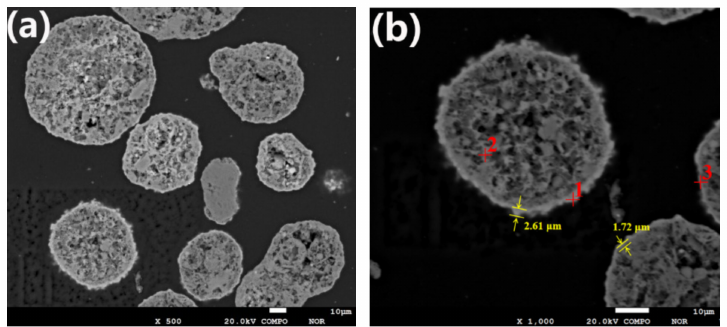
Figure 1. The contamination layers on the surface of SFCC catalyst particles: ( a ) cross-section of spent catalyst particles; ( b ) the thickness of the contaminated layer of spent catalyst